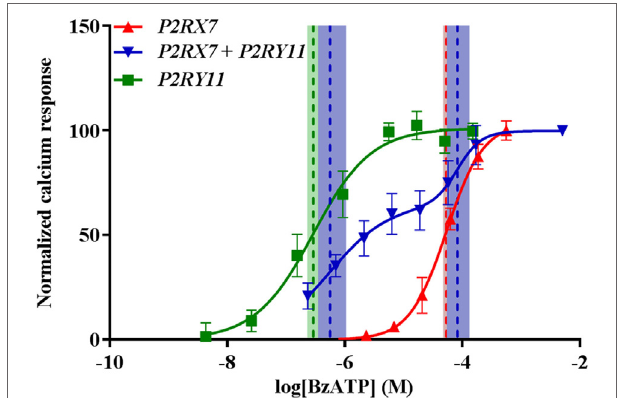
FigUre 6 | P2X7-mediated Ca 2 + response is still present when cells are cotransfected with P2RY11. Normalized calcium response measured by Fluo-4 following stimulation with various concentrations of BzATP of transiently transfected GripTite cells. Data are shown as mean ± SD, n = 9 from three independent experiments. Dose–response curves for P2RX7 (red) and P2RY11 (green) were fitted to a sigmoidal curve and cotransfected P2RX7 + P2RY11 to a biphasic sigmoidal curve. Vertical dashed lines represent EC 50 values for respective curves and 95% confidence intervals in colored shades. See text for